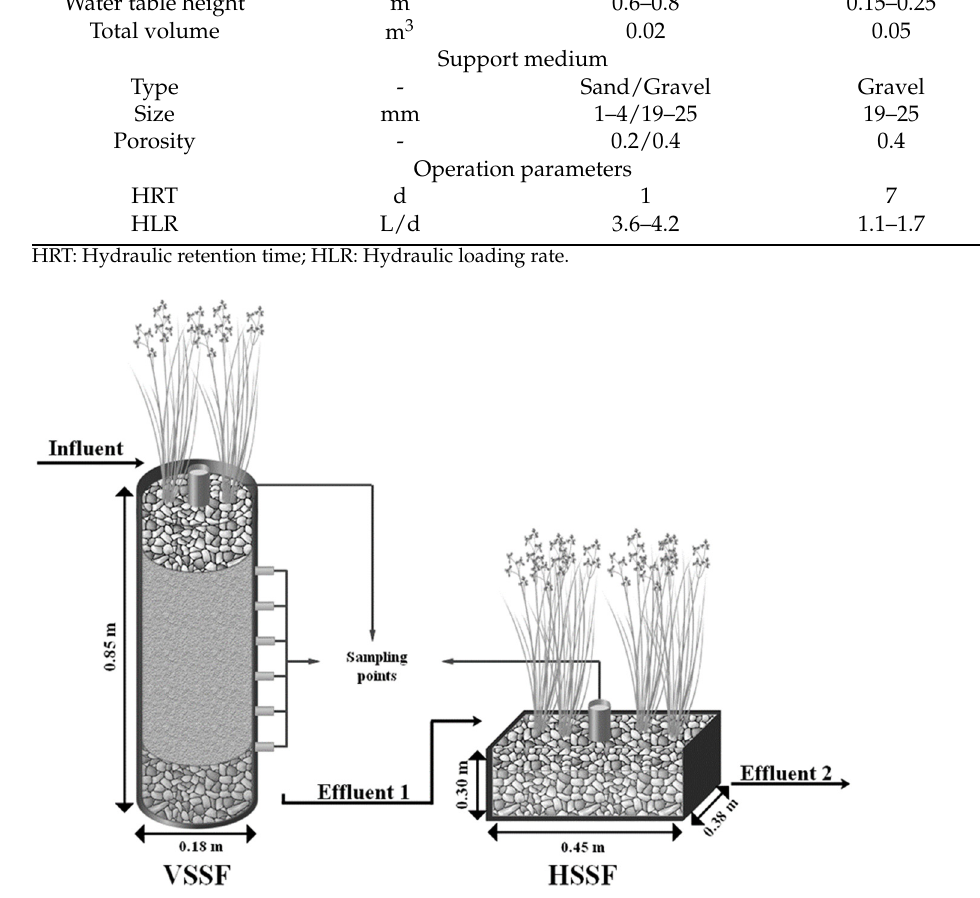
Figure 1. Schematic representation of hybrid constructed wetlands.